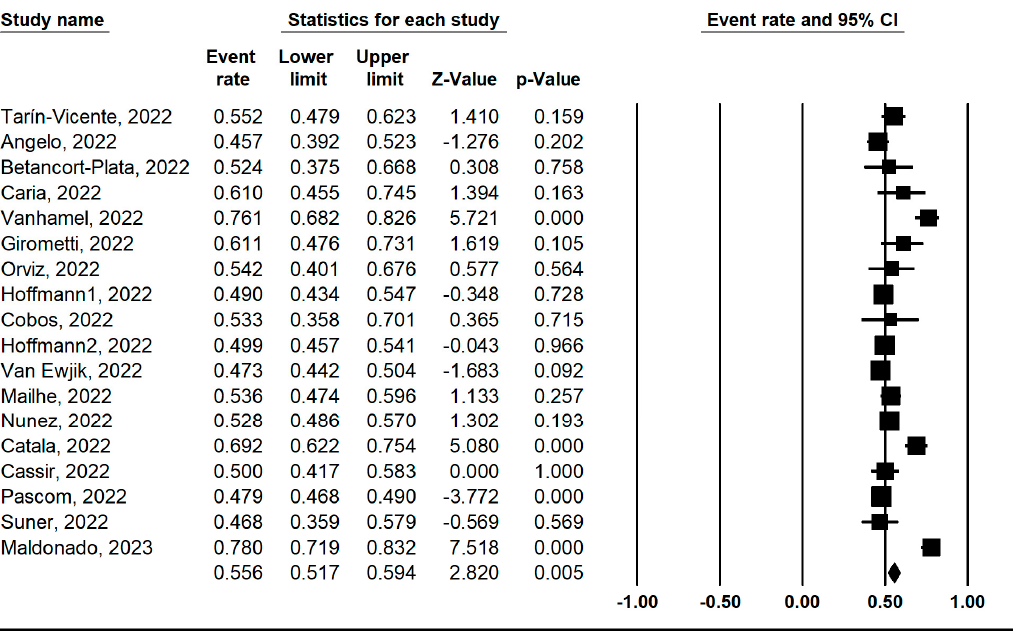
Figure 4. Pooled frequency of genitalia involvement in post ‐ 2022 studies. Tarín ‐ Vicente, 2022 [27],